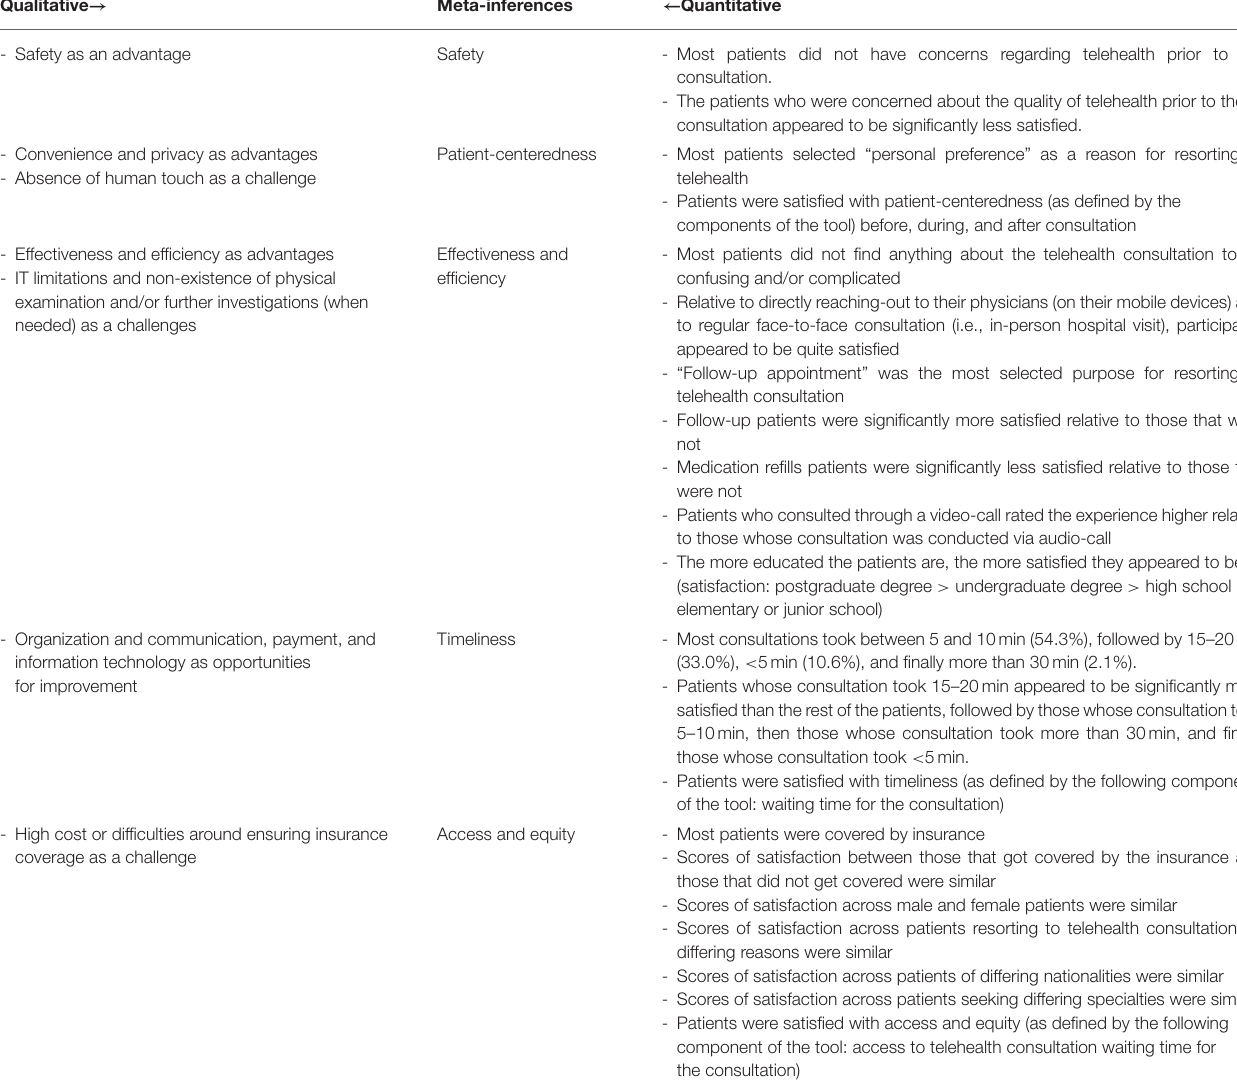
TABLE 4 | Output of the joint display